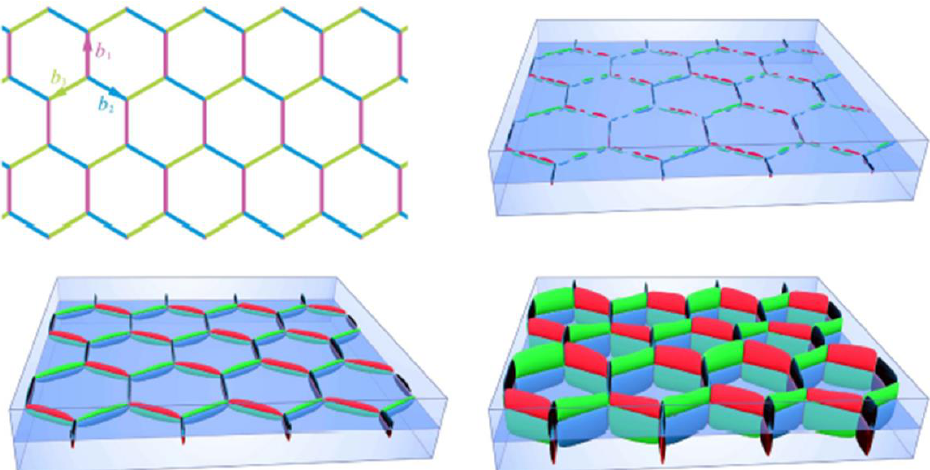
Figure 20. Morphology of honeycomb dislocation, the red circle part represents the triadic structure